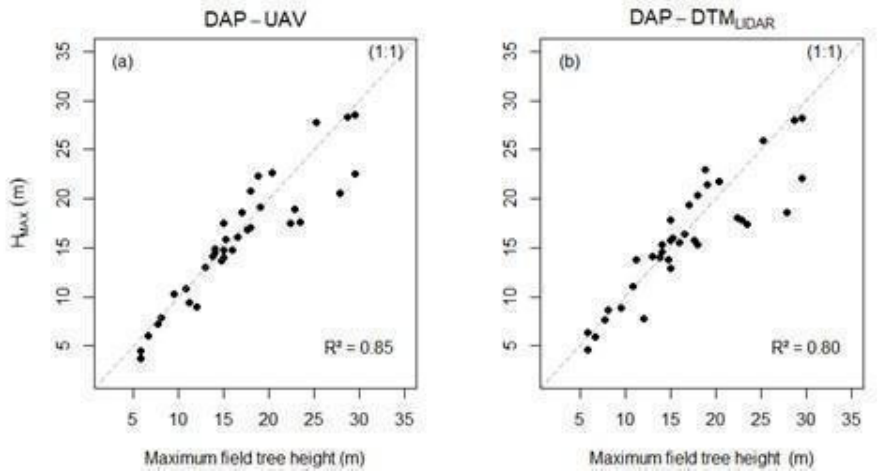
Figure 8. Scatter plots between the H max metric obtained by ( a ) DAP-UAV and ( b ) DAP-DTM LiDAR compared with the maximum heights of the field plots.